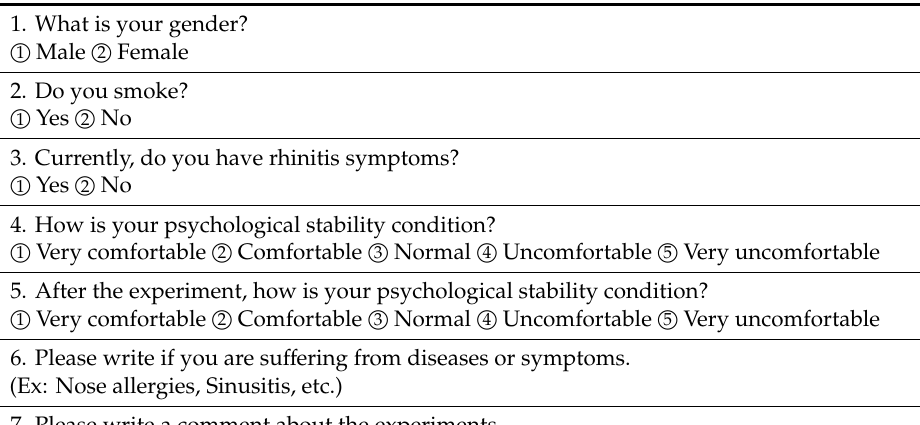
Table 4. Questionnaire for the evaluation for the e ff ects of mixed MTs on human